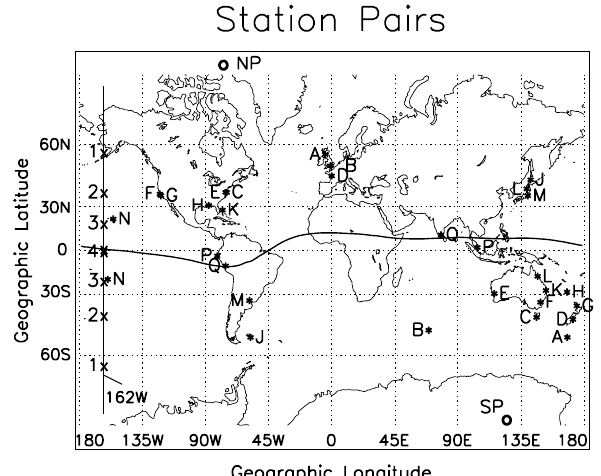
Fig. 1. Map of station pairs. Letters A-Q denote station pairs (Ta- ble 1). The vertical line with points 1-4 marks the 162 ◦ W meridian discussed in Sect. 4.3. The heavy circles denote the north and south magnetic poles as used in the CTIP model, and the magnetic dip equator is